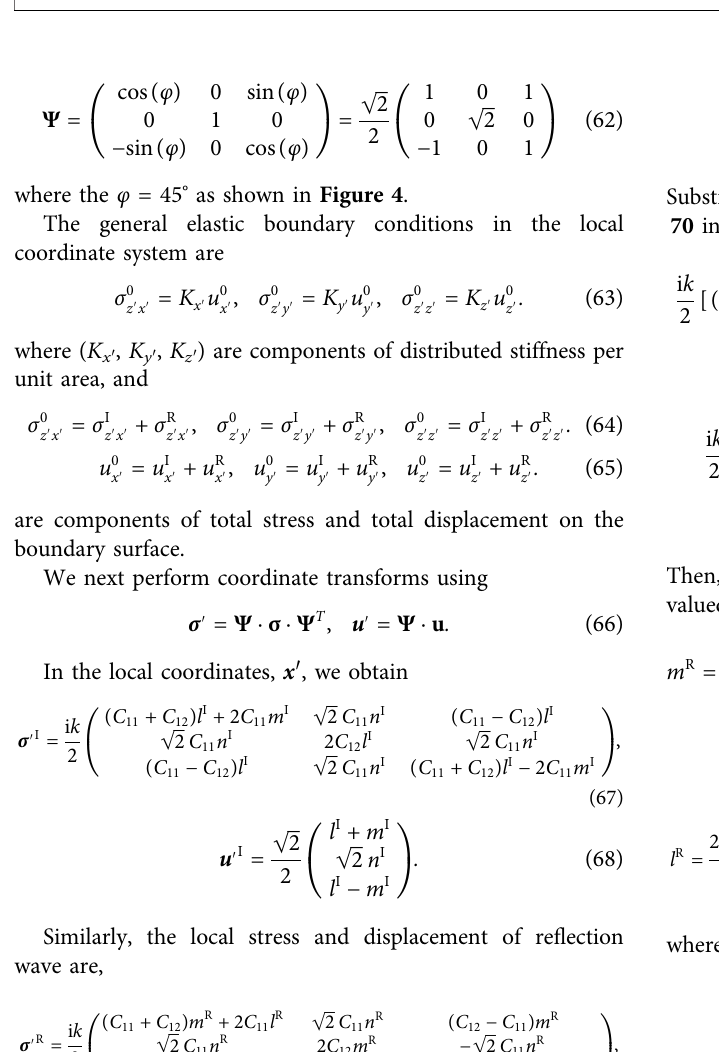
FIGURE4|(A) Illustrationofrollingwavere fl ectionsat45 ° incidence.Inallsub-plots, theincidence wavecarriesaspinangularmomentum, s I y (cid:2) + 1.Here s I and s R indicatethespindensityofincidencewaveandre fl ectionwave,respectively.Theycanbecalculatedusingthe eq.22 .There fl ectionprocessis (B) spin-preservingatthe fi xed rigid boundary, (C) spin-preserving at the free boundary, (D) spin- fl ipping at the fi xed-free boundary, and (E) spin- fl ipping at the free- fi xed boundary. Note that the free boundary in (C) has the specially effect of giving rise to an additional linearly polarized re fl ected wave. Although the spin is still exactly preserved, the overall re fl ected wave has an elliptical rolling